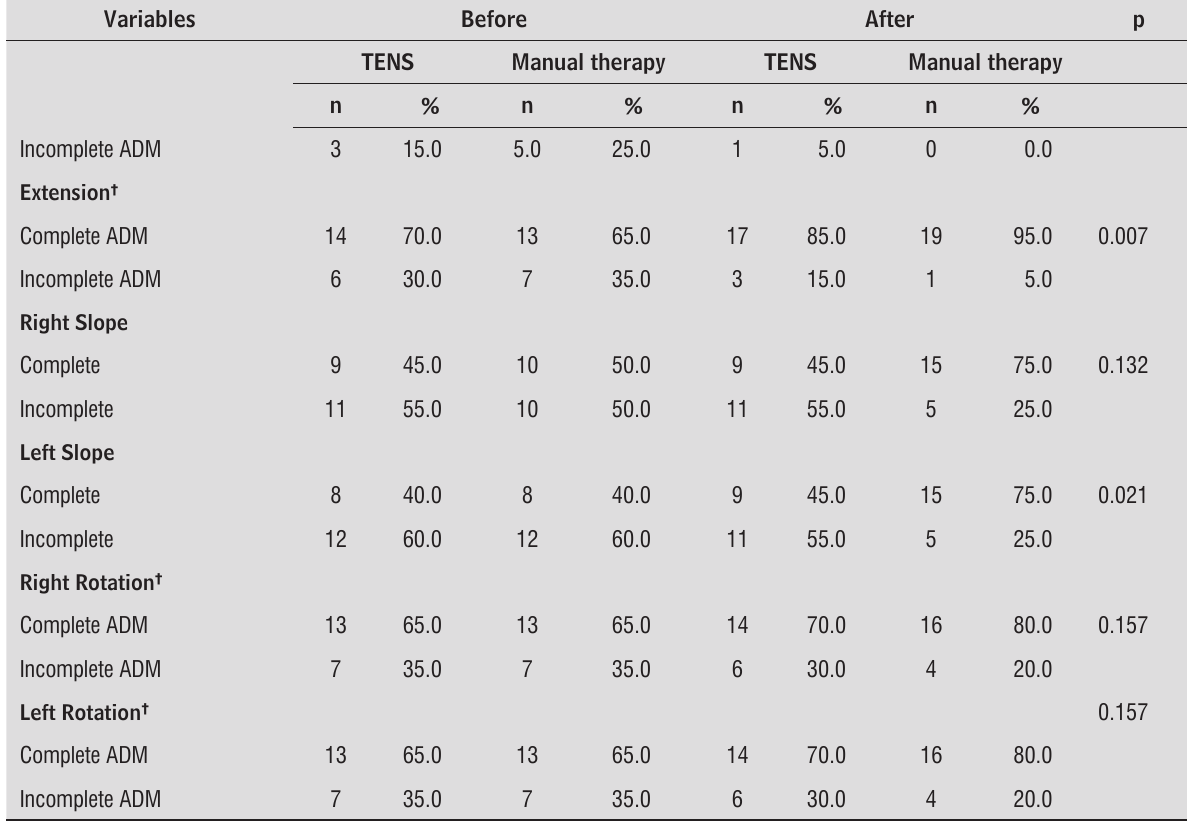
Table 3 - Comparison between TENS and manual therapy accordingly posture and clinical movement variable amplitude Before After p TENS Manual therapy TENS